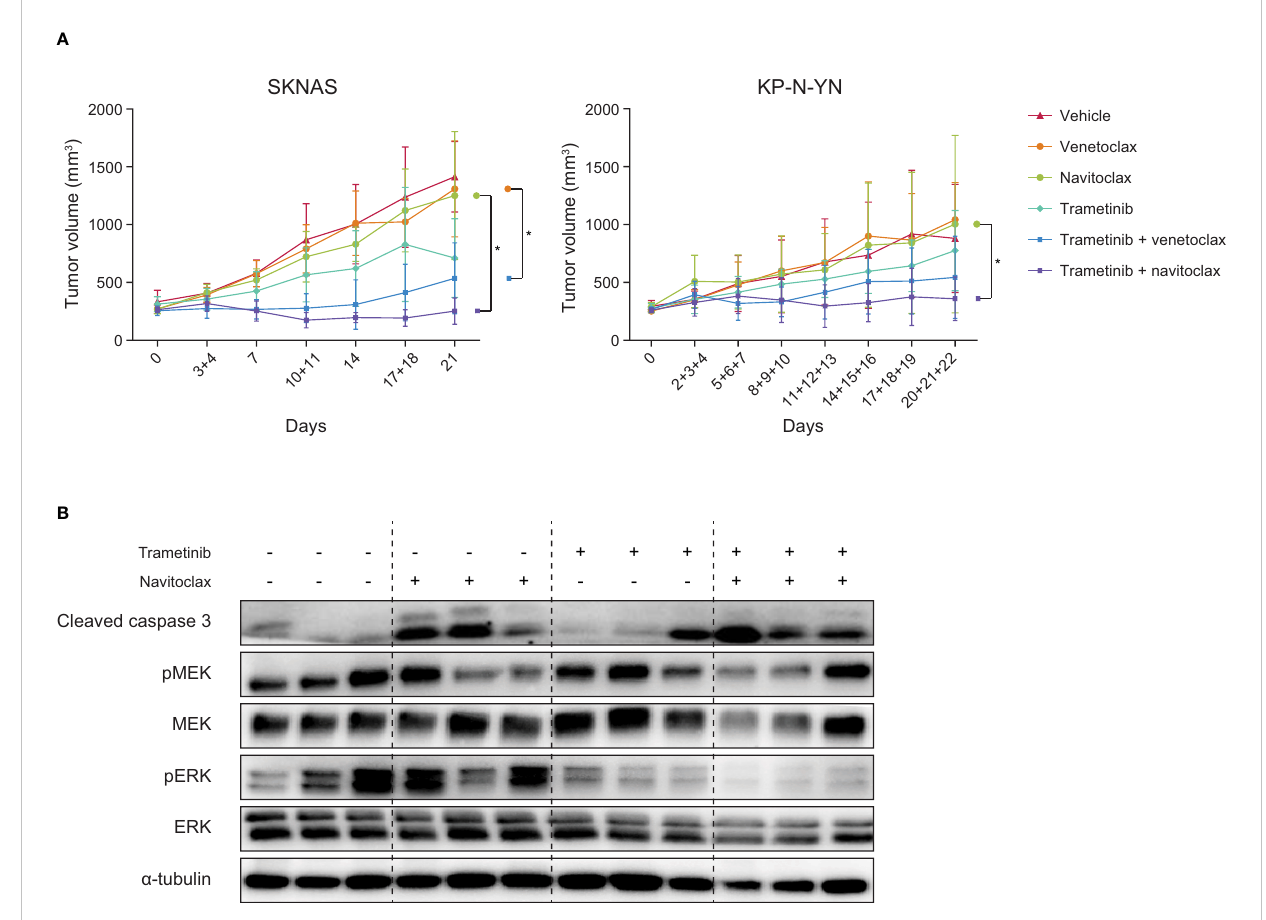
FIGURE 4 Combining navitoclax with trametinib enhances tumor growth inhibition in neuroblastoma xenografts. (A) Tumor growth curves of SKNAS and KP-N-YN xenografts treated with indicated compounds. Differences between treatment arms were analyzed using linear mixed effects modeling, with asterisks indicating a p-value <0.05. (B) Western blot of SKNAS xenografts treated for seven days with vehicle, navitoclax, trametinib or the combination. Tumors were harvested 4 h after the last